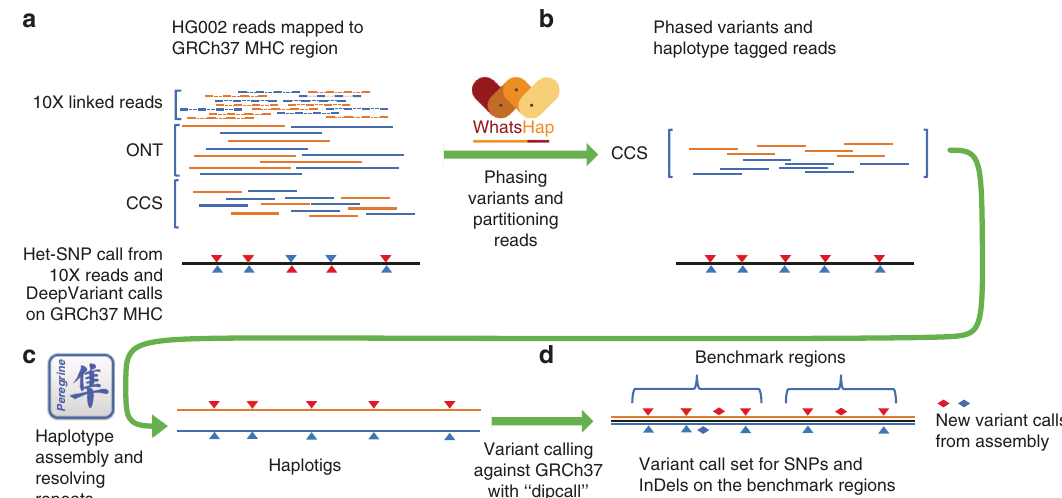
Fig. 1 Assembling a single contig for each haplotype. a We regenotyped DeepVariant (DV) heterozygous SNVs with WhatsHap using Oxford Nanopore Technologies (ONT) and PacBio HiFi (CCS) reads to fi nd a con fi dent set of SNVs with concordant genotypes from DV/CCS, WhatsHap/ONT, and WhatsHap/CCS — our Con fi dent HETs for phasing. We selected 10x Genomics (10X) variants with phased blocks from the 10X VCF. For phasing, we